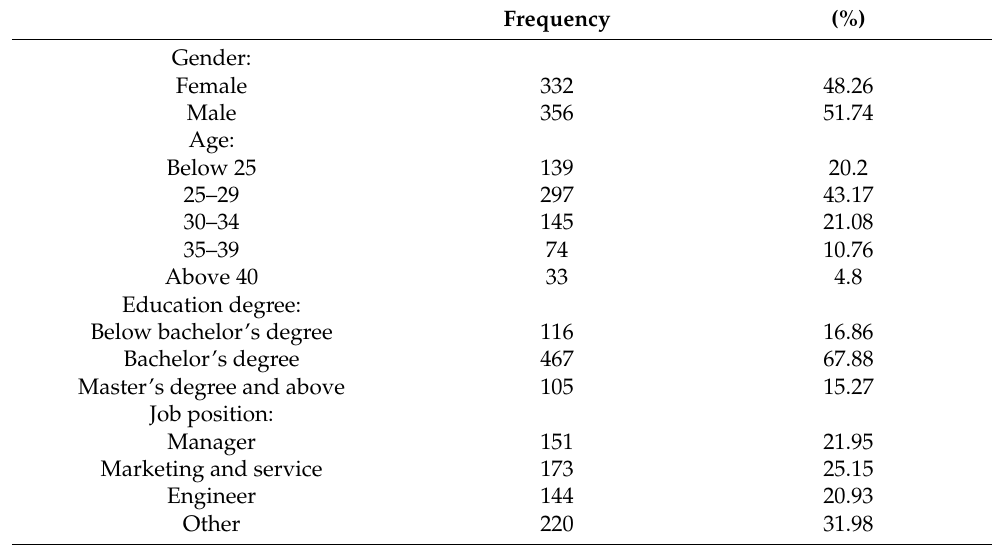
Table 1. Demographic characteristics of the